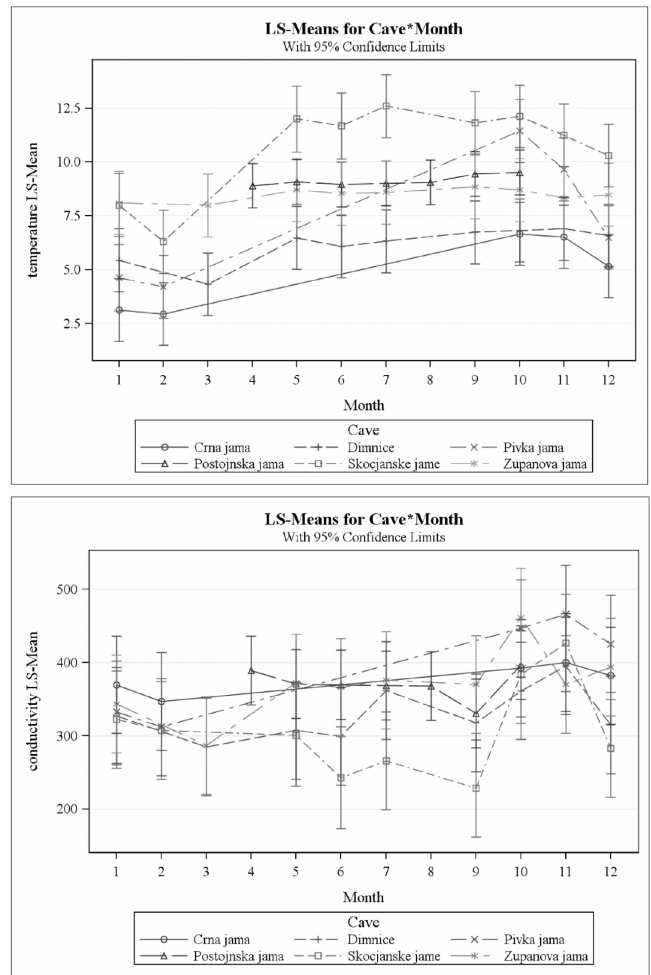
Figure 3. Temporal pattern of temperature (upper panel) and conductivity (lower panel). Vertical bars are 95% confidence intervals. For temperature, ˇCrna jama, Dimnice, Pivka jama, and Škocjanske jame had significant temporal variation. For conductivity, Dimnice, Pivka jama, Postojnska jama, Škocjanske jame, and Županova jama had significant temporal